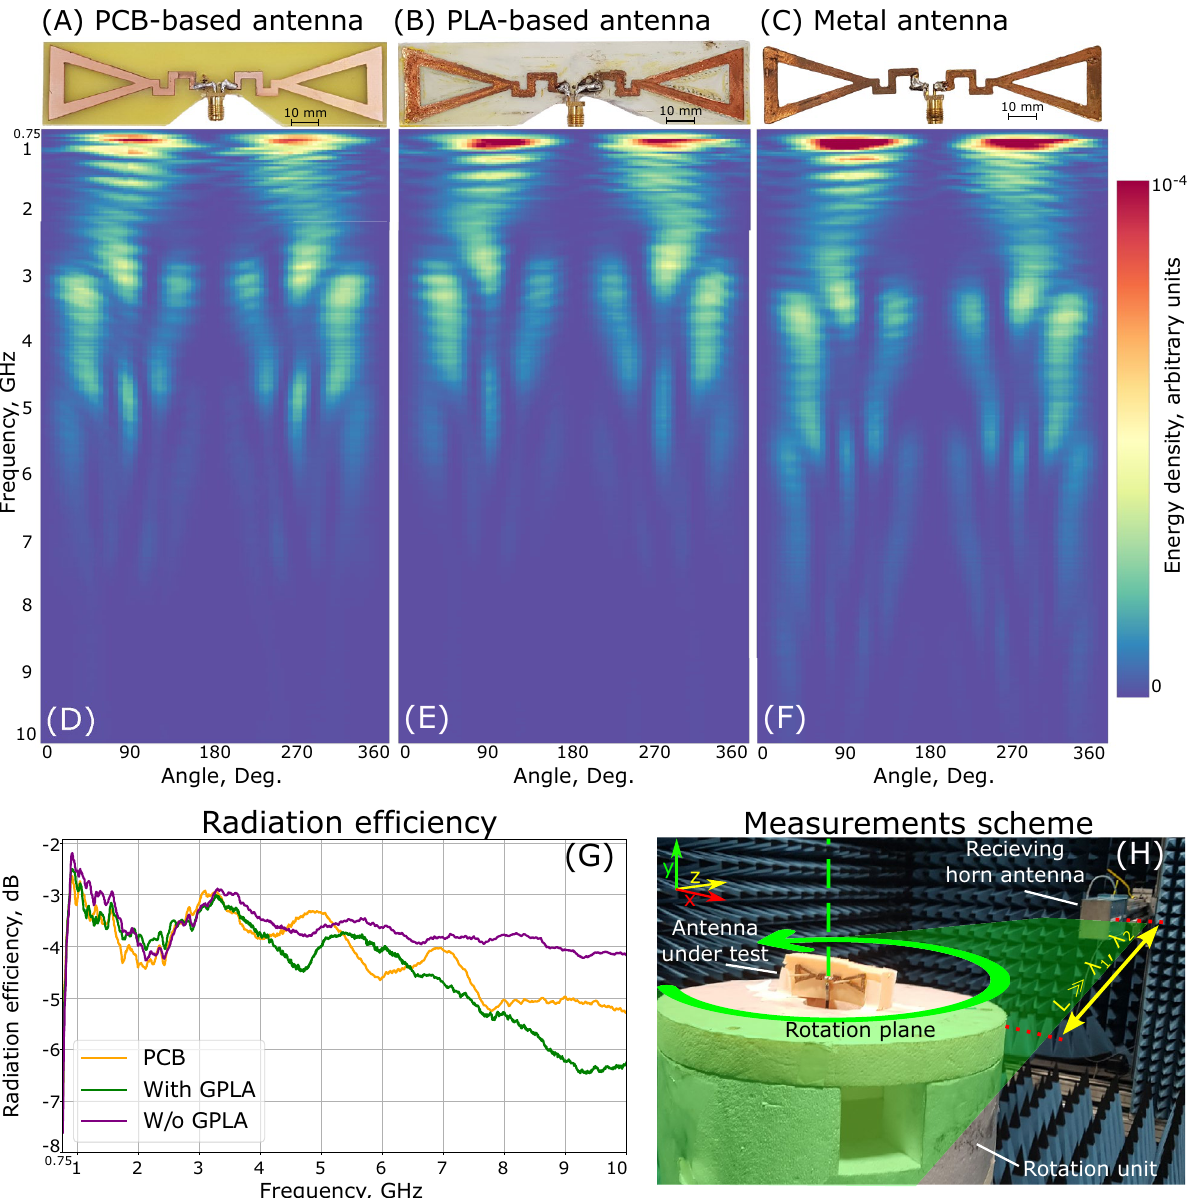
Figure 3. Experimental data representation. Comparison between ( A ) PCB-based, ( B ) GPLA substrate and ( C ) Free standing metal antennas. ( D – F ) Color maps of unwrapped radiation patterns (linear scale). Horizontal and vertical axes—angular and frequency dependences, respectively. Received energy is represented in linear scale, arbitrary units. ( G ) Radiation efficiency, as the function of frequency. PCB-based antenna—orange line, GPLA- based antenna—green, and metal antenna—purple. ( H ) Photograph of the experimental setup in an anechoic